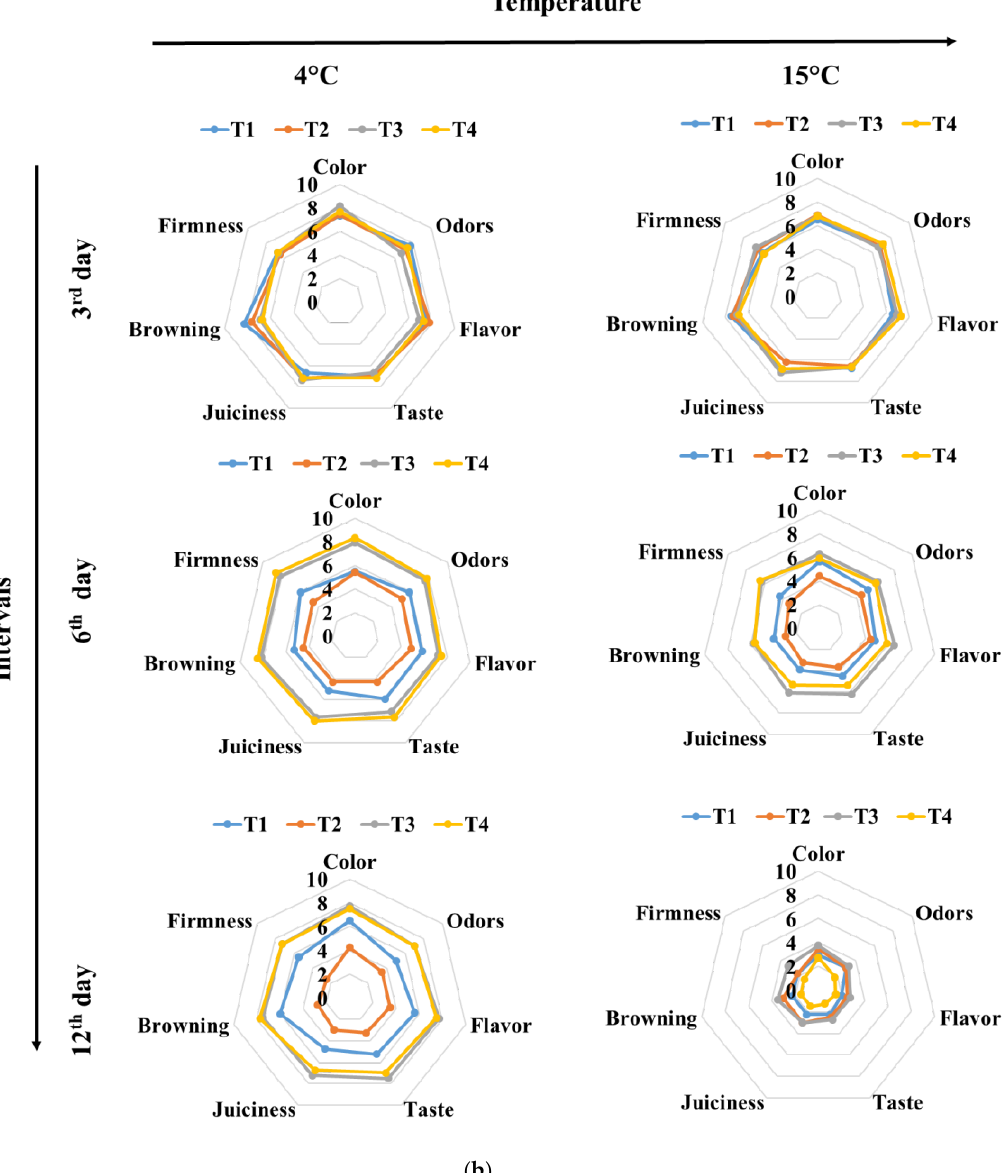
Figure 2. ( a ) Effect of the Lactobacillus rhamnosus GG and biochemical additives treatments on the sensory properties of red (R) fresh-cut bell pepper (FCBP) in comparison to day 4, day 6, and day 12 intervals. ( b ) Effect of the Lactobacillus rhamnosus GG and biochemical agent’s treatments on the sensory properties of yellow (Y) fresh cut bell pepper (FCBP) in comparison to day 4, day 6, and day 12 intervals.